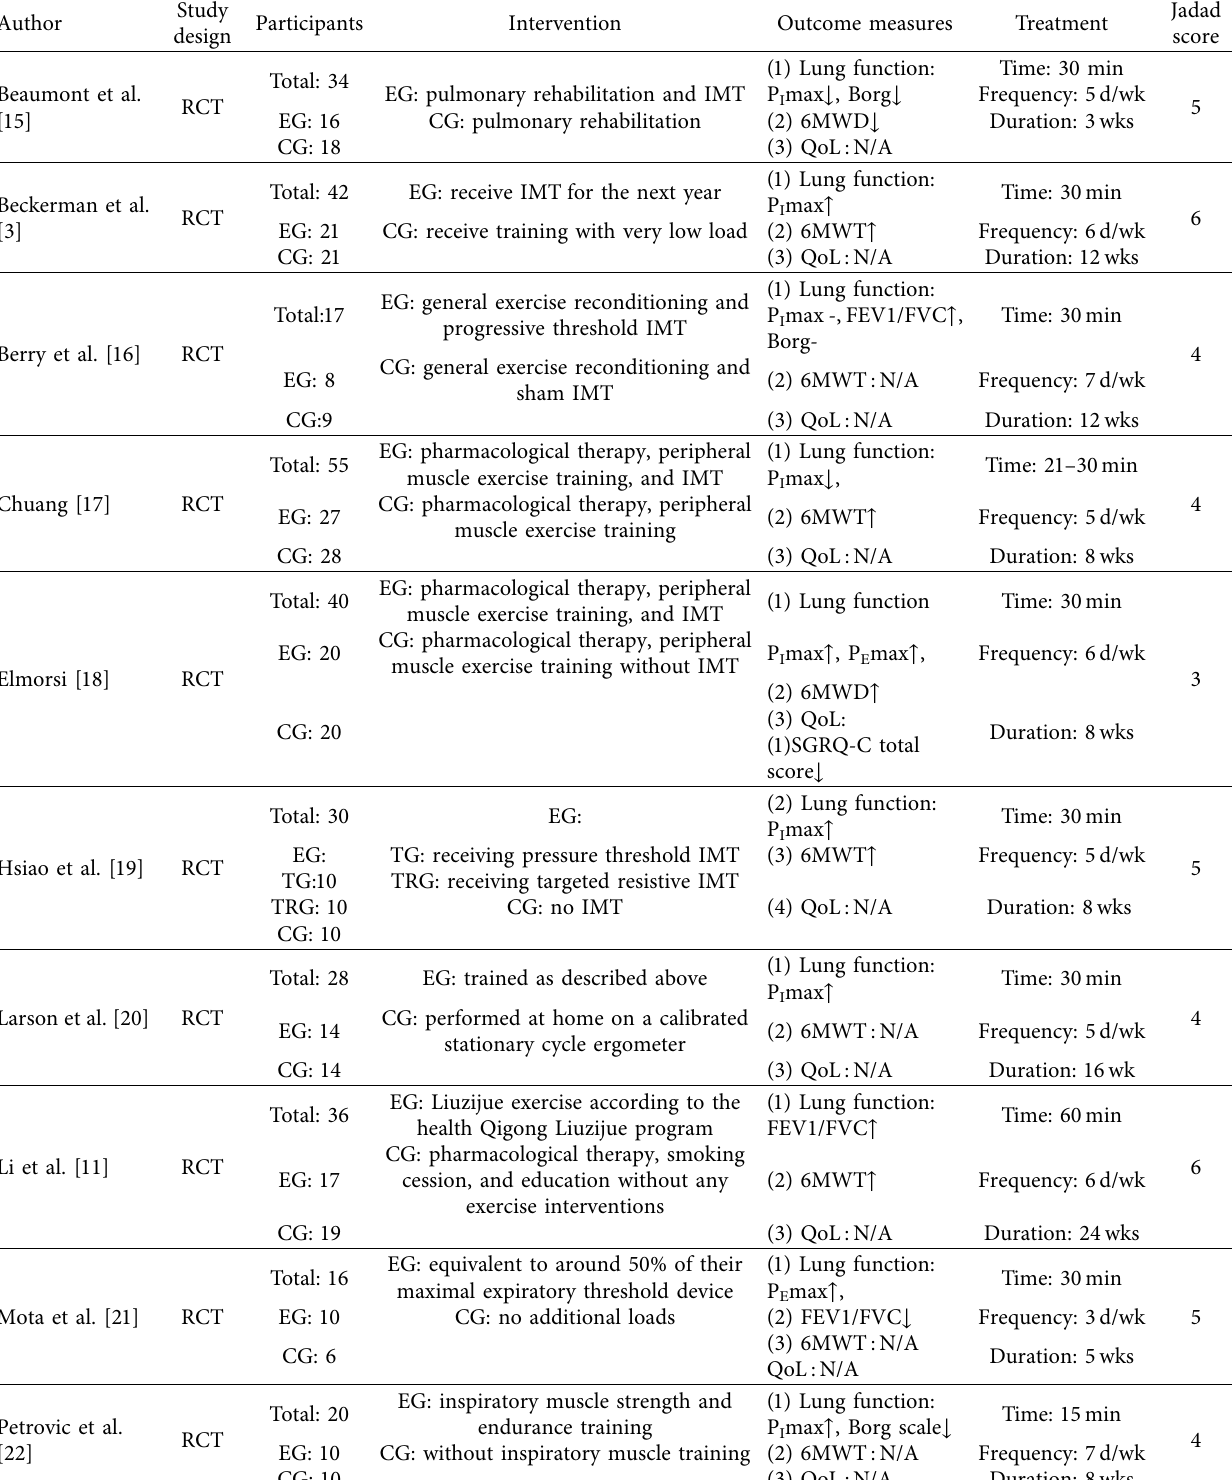
Table 1: Baseline demographics, interventions, and clinical characteristics of included